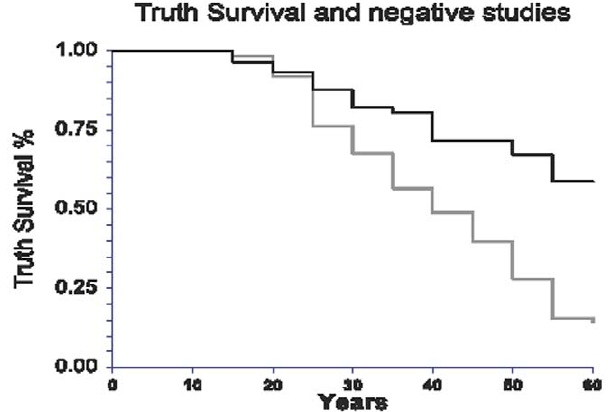
Figure 2. Survival of truth according to the Scholar Hirsch- index. Survival of 474 conclusions according to the h-index above the median value=24, or not, using the Google Scholar data-base from 1945 to 2009. There was no significant difference between 50 years survival, 50 6 5% (black line) and 46 6 4% (grey line), respectively (P=0.63).